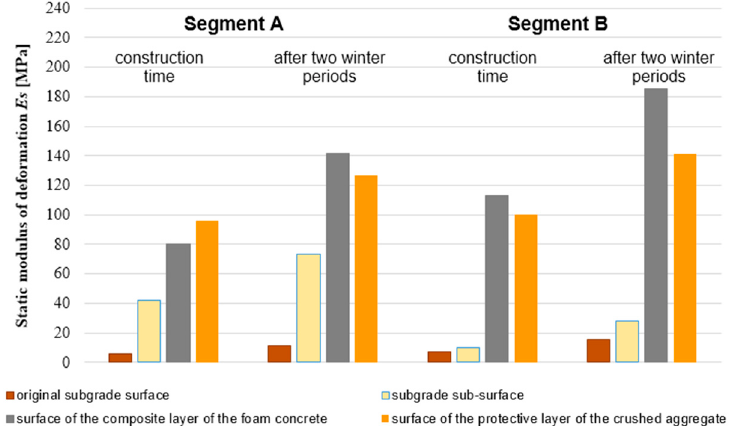
Figure 8. Average values of static deformation modulus E mat on the experimental field in segment A (with lower bearing capacity at the subgrade sub-surface and thickness of the composite layer of foamed concrete—0.10 m) and segment B (with higher bearing capacity at the subgrade sub-surface level and thickness 0.15 m of the composite layers of FC) during construction and after two winter periods.